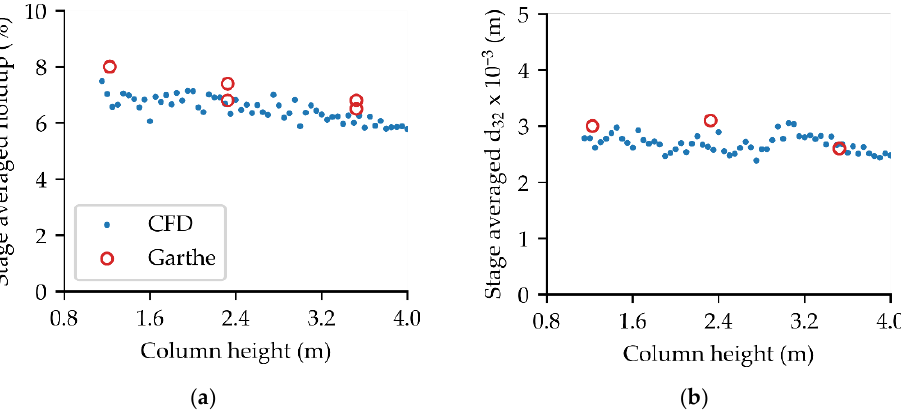
Figure 4. Stage-averaged results along the RDC compared to experimental values [5] for: ( a ) dispersed phase holdup; ( b ) Sauter mean droplet diameter.